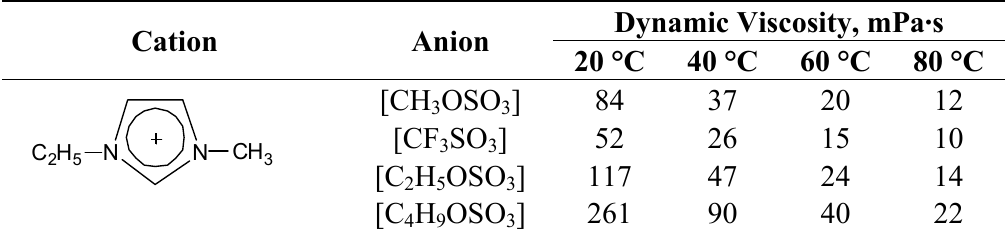
Table 3. Viscosity of 1-ethyl-3-methylimidazolium triflate (EMIM OTF) in comparison